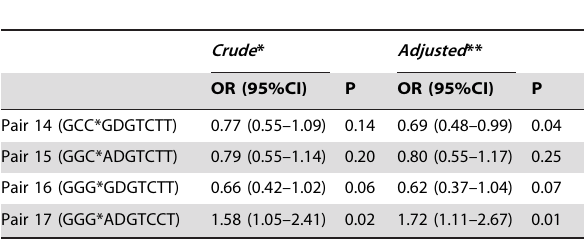
Table 2. Estimated effect of haplotype pairs 14, 15, 16 and 17 on the risk of MI.